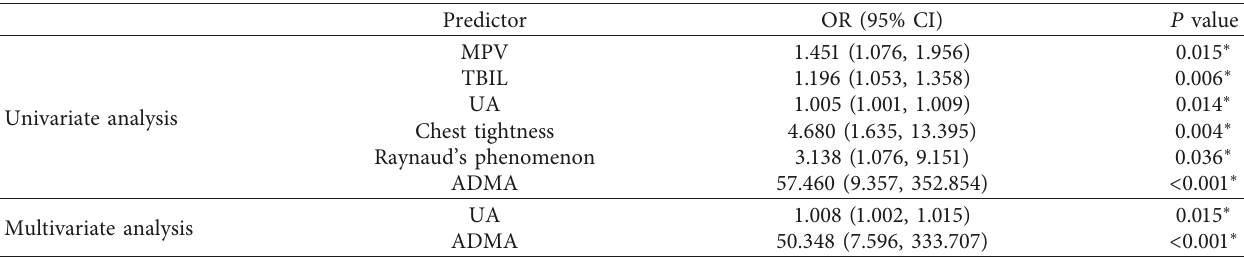
Figure 2: Association of serum ADMA levels with sPAP, NT-proBNP, and DlCO%. Scatter plots of the relationship in serum ADMA concentration. A: sPAP ( r � 0.802, P < 0 . 05), B: NT-proBNP ( r � 0.475, P < 0 . 05), and C: DLCO% ( r �− 0.585, P < 0 . 05), in 88 CTD patients. Table 4: Univariate and multivariate